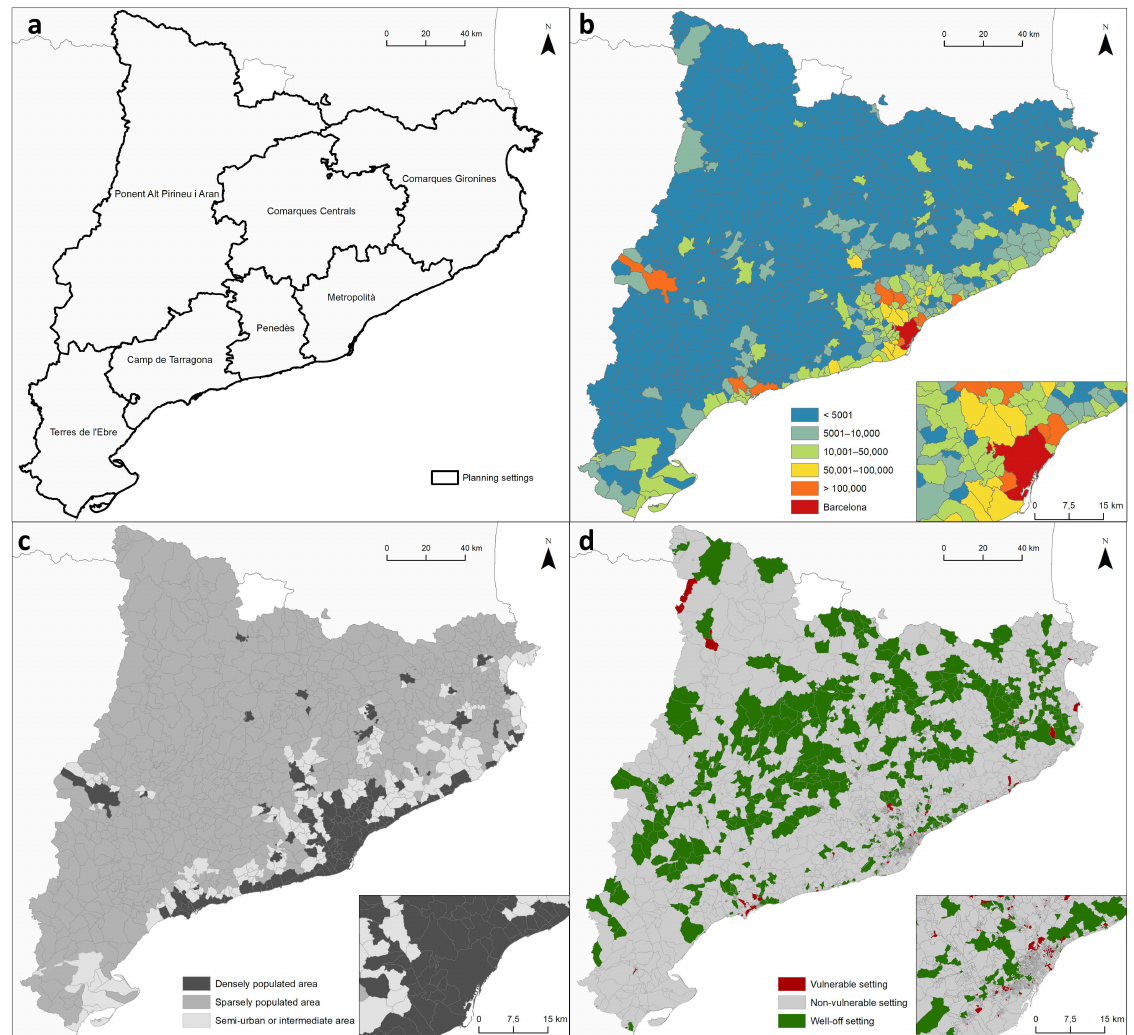
Figure 1. Territorial settings, Catalonia. ( a ) Planning settings; ( b ) Population size; ( c ) Urban/rural character; ( d ) Residential segregation. Source: In-house construction based on cartography from Institut Cartogr à fic i Geol ò gic de Catalunya, inhabitants data from (IDESCAT), Urban/rural character from [14,63] and Residential segregation from